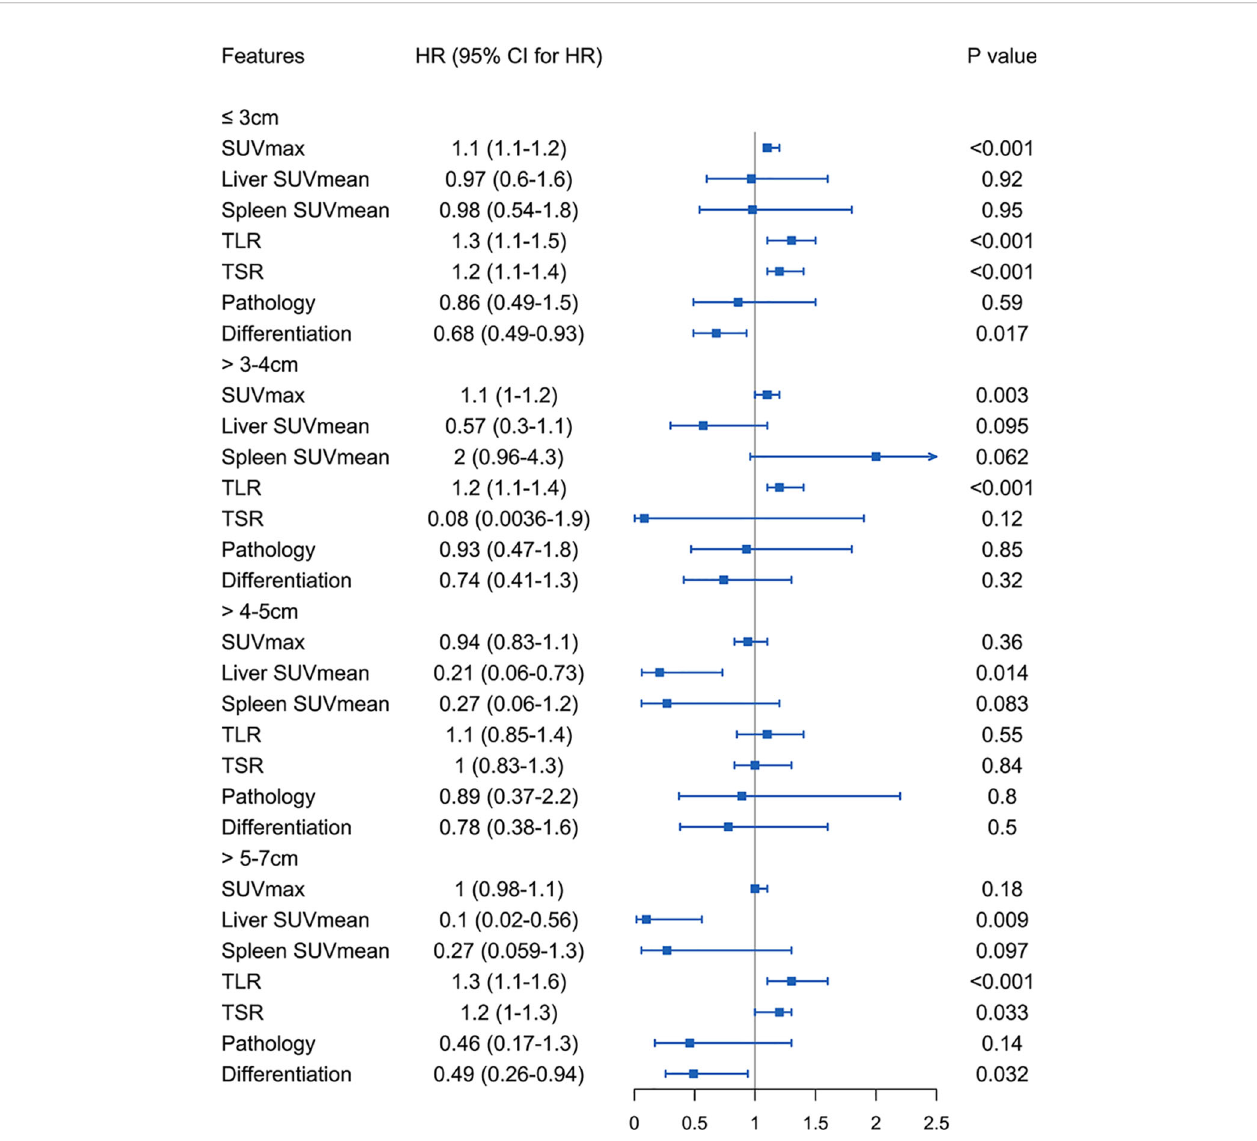
FIGURE 3 | Four groups of patients strati fi ed by tumor size using imaging metabolic indicators and pathological features to analyse the risk of